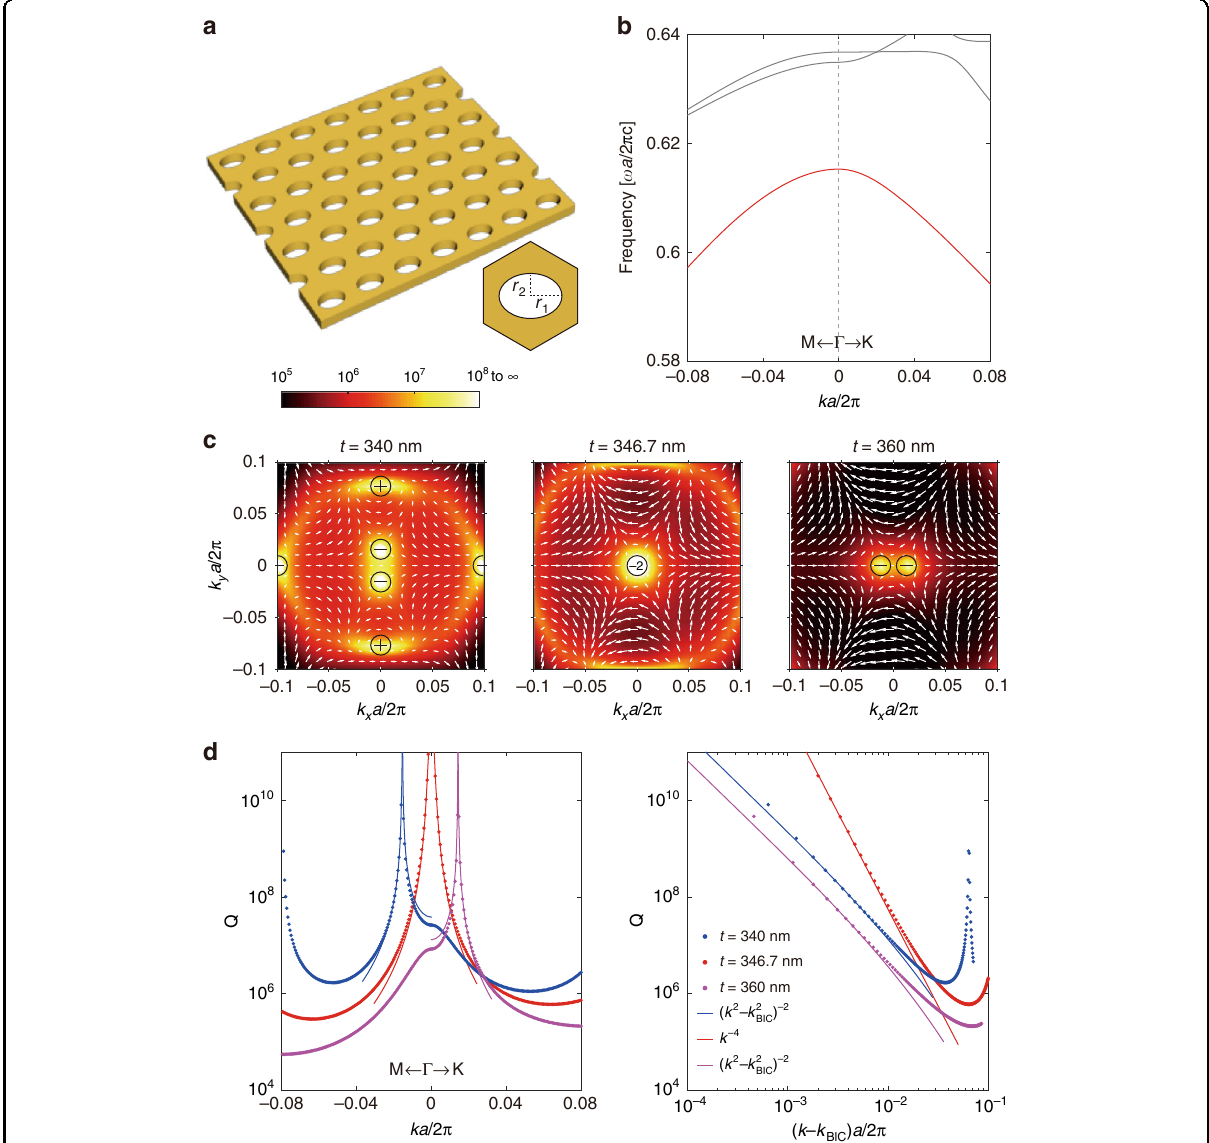
Fig. 2 Merging split BICs at Γ . a Schematics of a PCS with a triangular lattice (lattice constant a = 336 nm) of elliptic cylindrical etched holes. The semi-major axis and semi-minor axis are r 1 = 112 nm and r 2 = 80 nm, respectively. The materials of the PCS and the background are the same as Fig. 1. The inset is the top-view of the unit cell. b Simulated TE-like band structure at t = 340 nm. The lowest TE-like band is highlighted in red. c Simulated polarization vectors around BICs with Q factors as background for the lowest TE-like band at different thicknesses. When t is tuned from 340 nm to 360 nm, the two split BICs with the same topological charge − 1 bounce off each other. The transition ( t = 346.7 nm) corresponds to a merging BIC with charge − 2. d Simulated Q factors (dotted lines) and fi tting curves (solid lines). The merging BIC case has considerably enhanced Q factors for nearby states compared with the isolated BICs